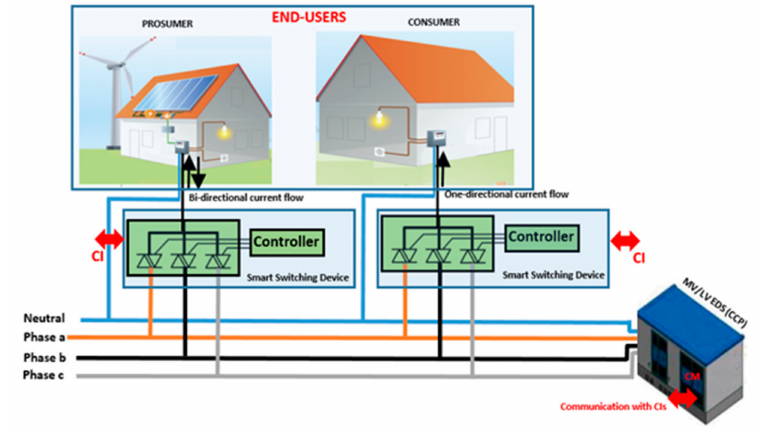
Figure 3. The centralized control of the Smart Switching